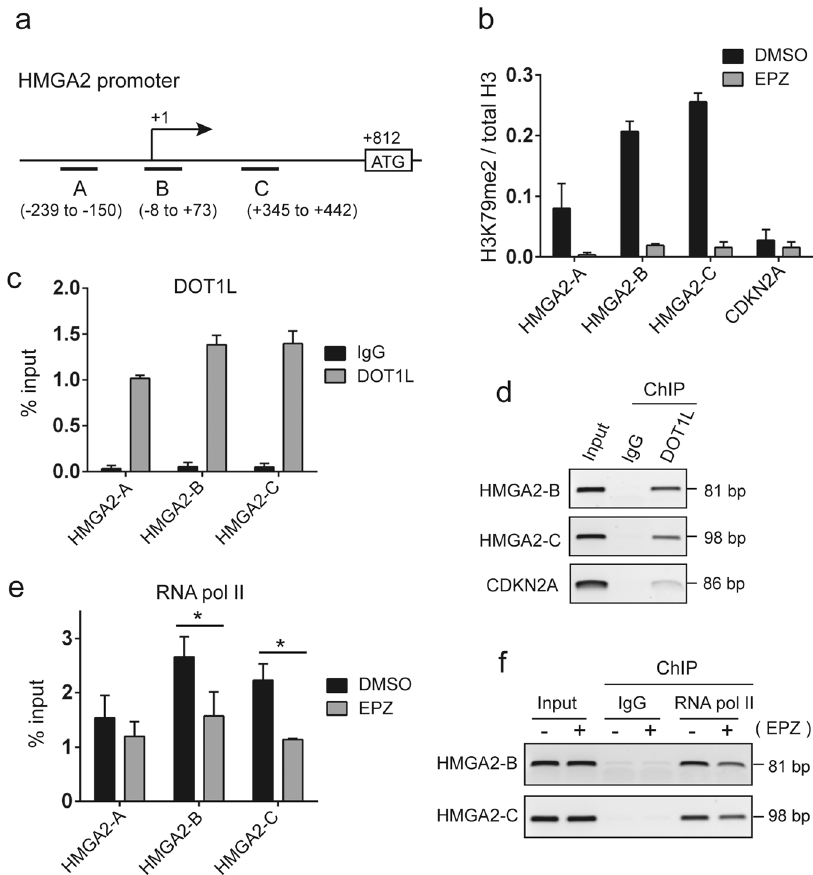
Fig. 4 HMGA2 is a DOT1L target gene. a Schematic of the HMGA2 promoter structure near the transcription start site, with the location of primers used for ChIP assays. b ChIP-qPCR analysis for H3K79me2 enrichment at different locations of the HMGA2 promoter. Y79 cells were treated with 10 µM EPZ5676 for 6 days before the ChIP assays. The CDKN2A promoter is repressed in Y79 cells and shown as a negative control. The data represent the mean ± SD of normalized H3K79me2/total H3 ratios ( N = 3). c , d DOT1L binding at the HMGA2 promoter determined by ChIP-qPCR ( c ) and PCR-gel ( d ) analyses. The graph is shown as the mean ± SD of % input ( N = 3). e , f RNA pol II association at the HMGA2 promoter determined by ChIP-qPCR ( e ) and PCR-gel ( f ) analyses in Y79 cells treated with 10 µM EPZ5676 for 6 days. The graph represents the mean ± SD of % input ( N = 3). * P <